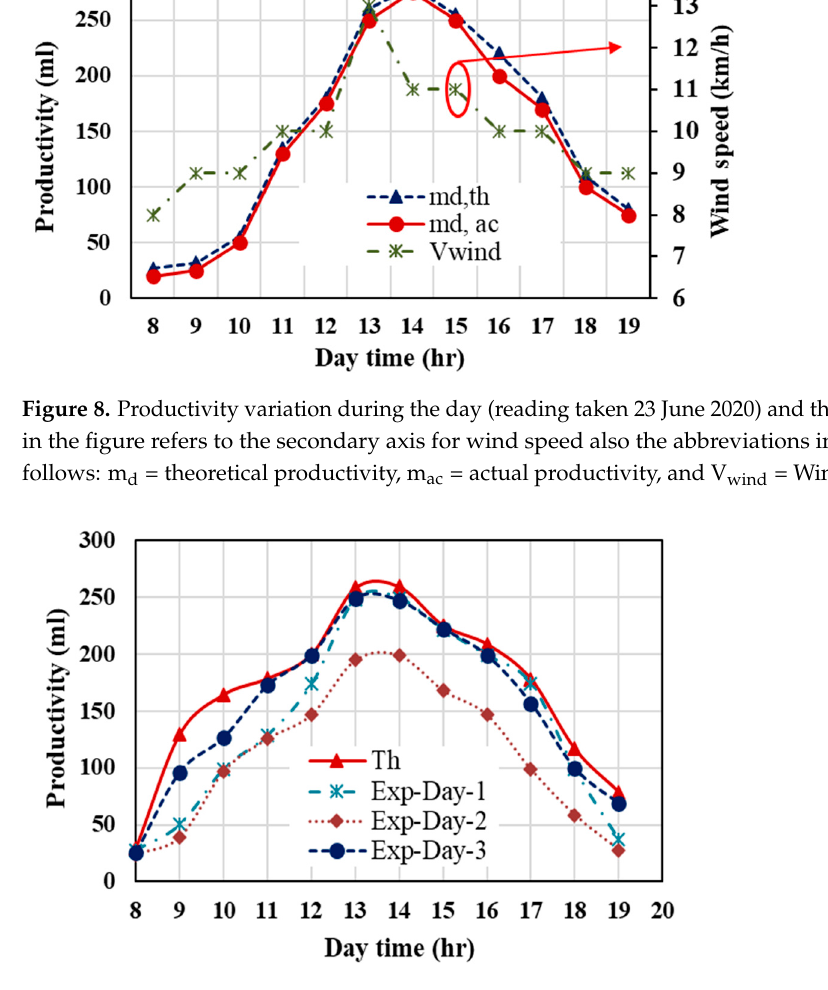
Figure 9. Productivity variations in three typical days and the abbreviations in the figure are as follows: T h = theoretical and Exp = experimental.